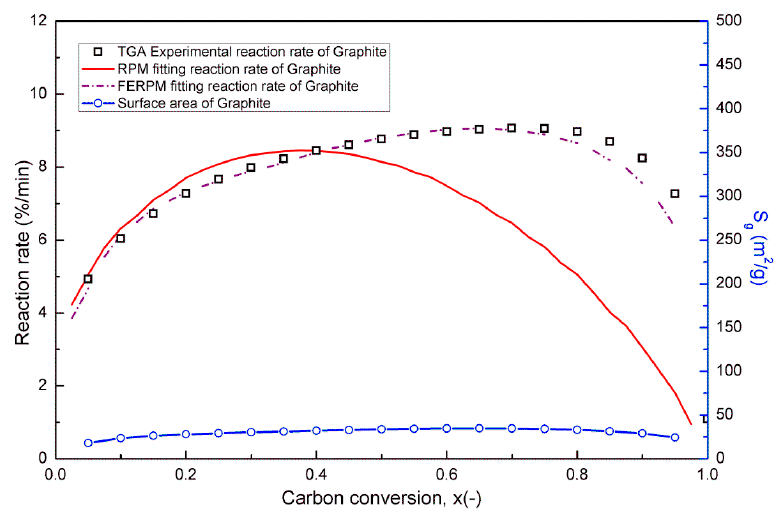
Figure 4. Oxidation reaction rates and surface areas ( S g ) for the carbon conversion of graphite as calculated by the RPM and FERPM using TGA apparatus. Table 3. Calculated structural parameters ( ψ ), FERPM parameters, and initial particle surface areas ( S 0 ) of low-rank coal char and graphite.